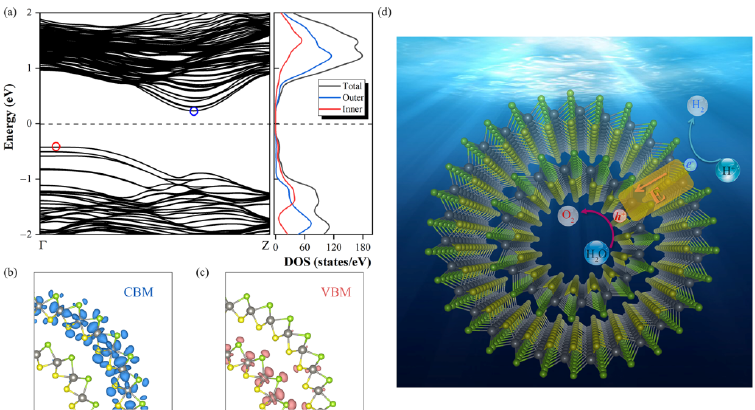
Figure 6. The electronic properties of WSSe DWNT1 ( a ), including the projected density of state (right) and band structure (left). The Fermi level (labeled with the dashed line) is set to 0 eV. The spatial distributions of ( b ) CBM (blue areas) and ( c ) VBM (pink areas) of WSSe DWNT1 . We set the isosurface value to 1 × 10 −3 e/Å 3 . ( d ) The work mechanism of WSSe DWNT1 for photocatalytic wa- ter-splitting.